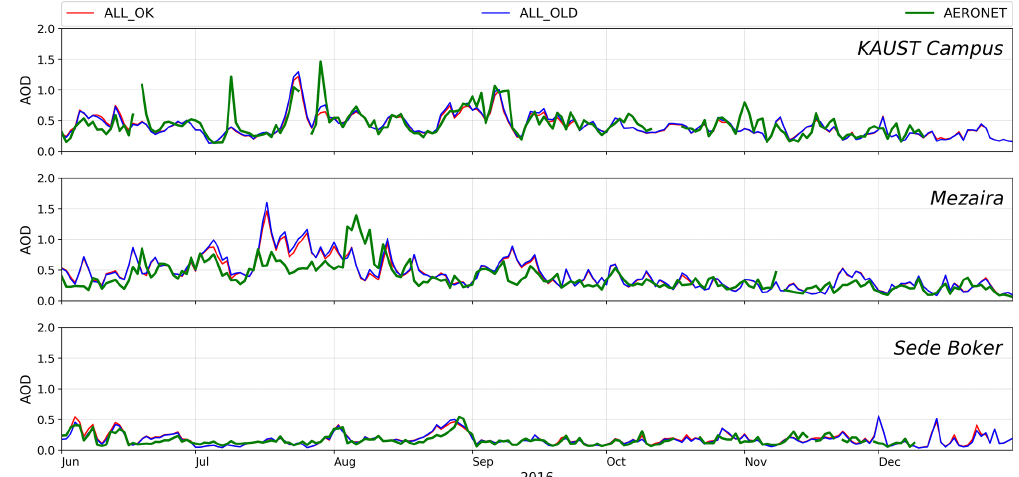
Figure 7. Daily averaged AOD time series from the ALL_OK and ALL_OLD runs (red and blue lines) and AERONET AOD (green line) at KAUST Campus, Mezaira, and Sede